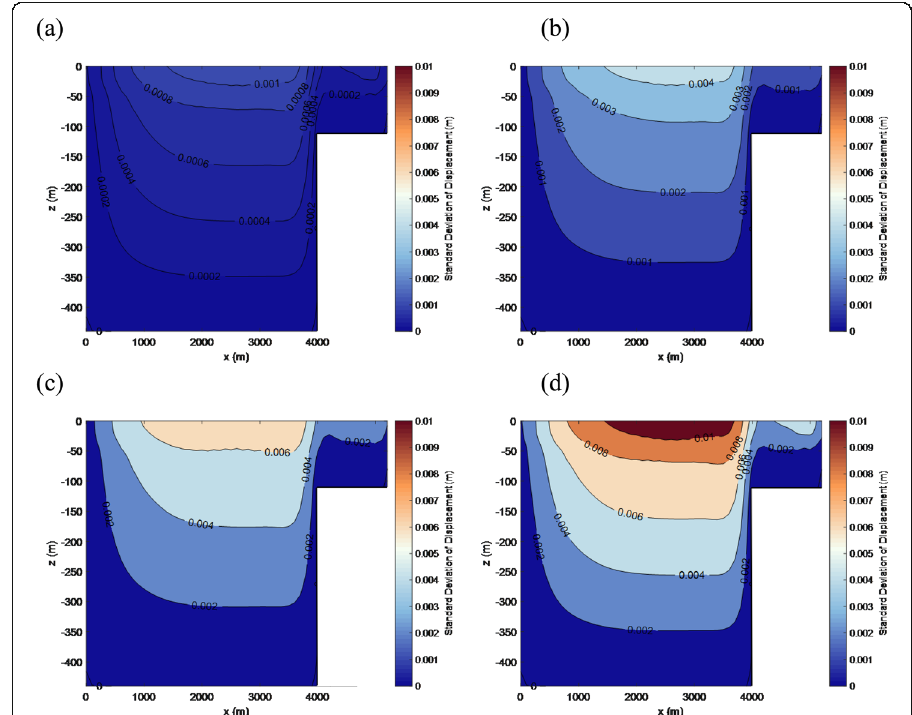
Fig. 12 Uncertainty of displacement over the years considering the spatial variability of k a ( l x = 200 m, l z = 40 m, COV = 0.8). a Year 1. b Year 4. c Year 7. d Year